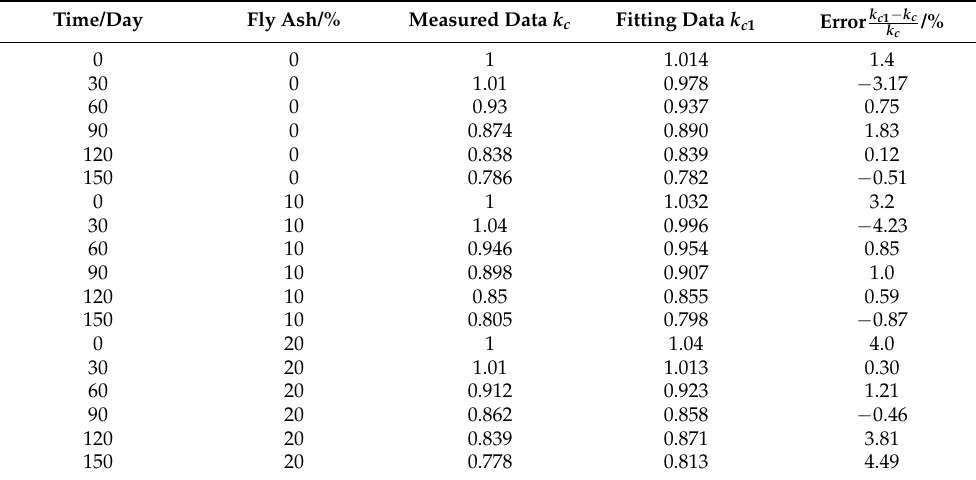
Figure 10. Relationship between fly ash content and erosion time n with k c . It can be seen from Table 4 that the error between the calculated values and the measured values of the regression formula is small. Among these, the minimum error without fly ash occurred at 120 d of sulfate erosion, with an error of 0.12%. The maximum error was − 3.17% at 30 d of sulfate attack. When the fly ash content was 10%, the minimum error occurred at 120 d of sulfate attack, with an error of 0.59%. The maximum error was − 4.23% at 30 d of sulfate attack. When the fly ash content was 20%, the minimum error occurred with a sulfate erosion lasting 30 d, with an error of 0.30%. The maximum error occurred at 150 d of sulfate attack with an error of 4.49%. For engineering practices and measurement errors, this is negligible; hence, the test value and the fitting value are basically the same. Table 4. Comparison of fitting k c1 and measured k c .